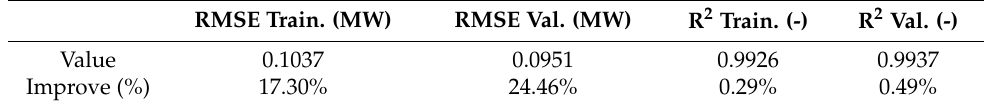
Table 7. Computed RMSE and R 2 index values for optimal SVM model.